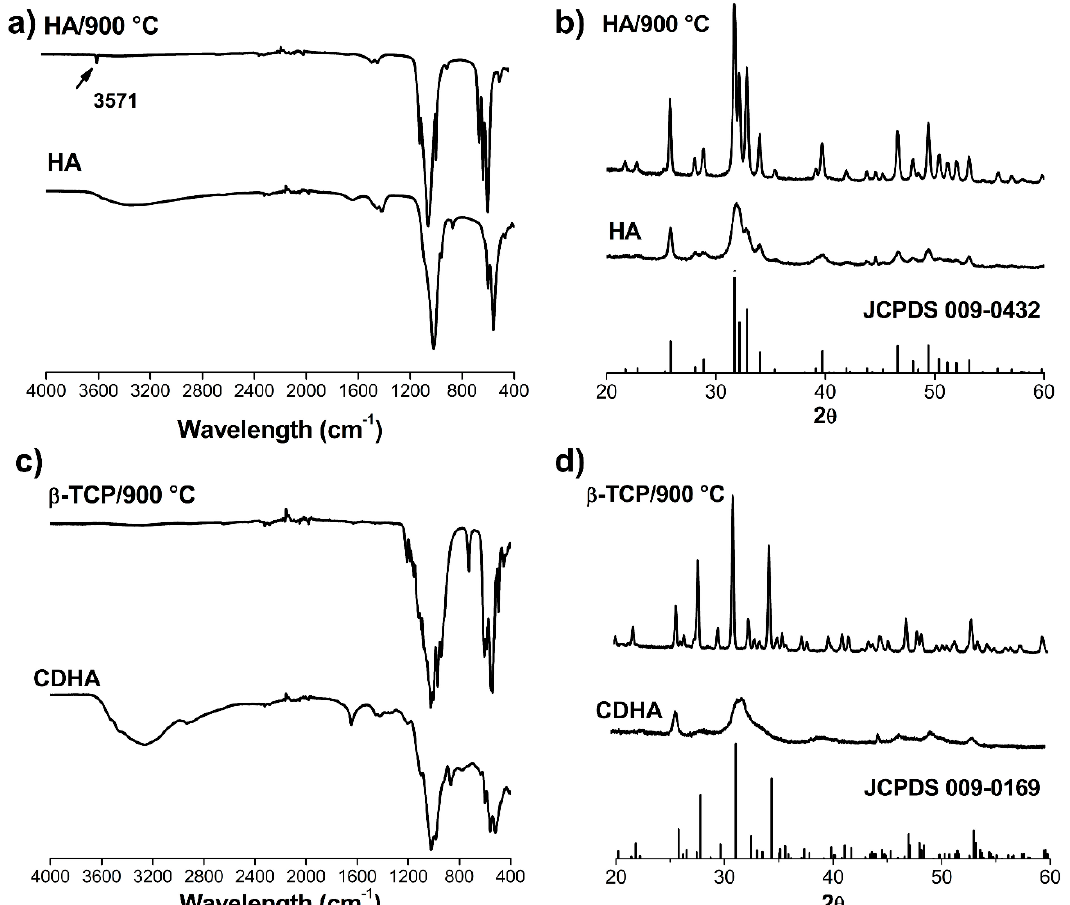
Figure 2. Chemical and crystallographic characterization of hydroxyapatite (HA) and poorly crystalline calcium deficient hydroxyapatite (CDHA) particles synthesized and heat-treated at 900 ◦ C. ( a , c ) FTIR spectra; ( b , d ) XRD patterns.